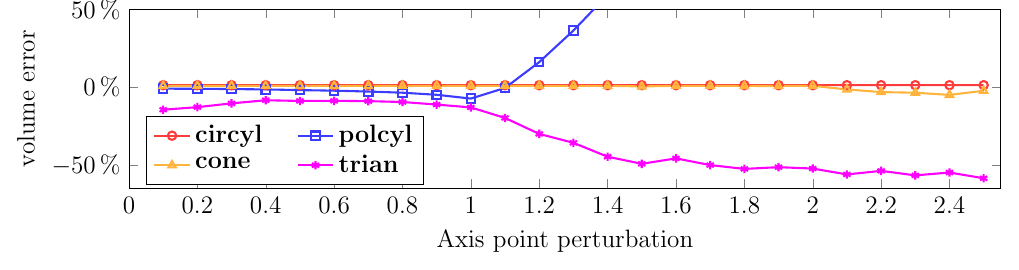
Figure 4. Relative volume error as a function of axis point estimate perturbation. The magnitude of the transition was received by multiplying the radius estimate by the scaling factor shown on the horizontal